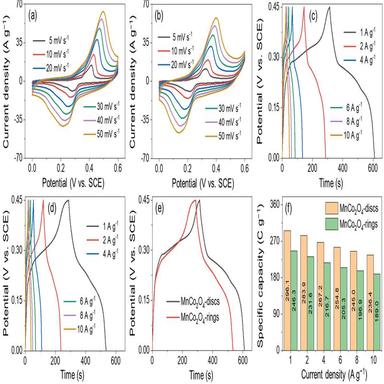
CV curves of (a) MnCo2O4-discs and (b) MnCo2O4-rings at a scan rate of 5 − 50 mV s − 1 , the GCD curves of (c) MnCo2O4-discs and (d) MnCo2O4-rings under a current load of 1 − 10 A/g, (e) the GCD curves of MnCo2O4-discs and MnCo2O4-rings at 1 A/g, and (f) the rate performance of MnCo2O4-discs and MnCo2O4-rings.